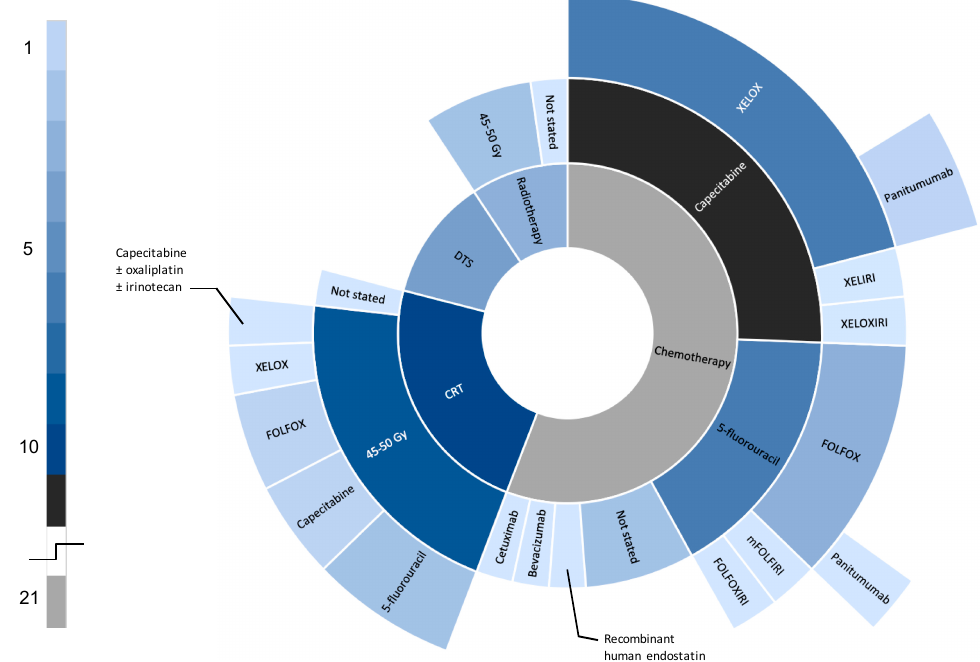
Figure 3. Neoadjuvant therapies in the current literature. (Categories are not mutually exclusive. Some trials evaluated more than one neoadjuvant therapy). DTS, direct-to-surgery; CRT, chemoradiotherapy; FOLFOX, folinic acid + 5-fluorouracil + oxaliplatin; FOLFOXIRI, FOLFOX + irinotecan; mFOLFIRI: 5-fluorouracil + irinotecan; XELOX, capecitabine + oxaliplatin; XELOXIRI, XELOX + irinotecan; XELIRI, capecitabine + irinotecan; NAC, neoadjuvant chemotherapy; NAR, neoadjuvant radiotherapy. Table 2. Neoadjuvant regimens as detailed by included studies.